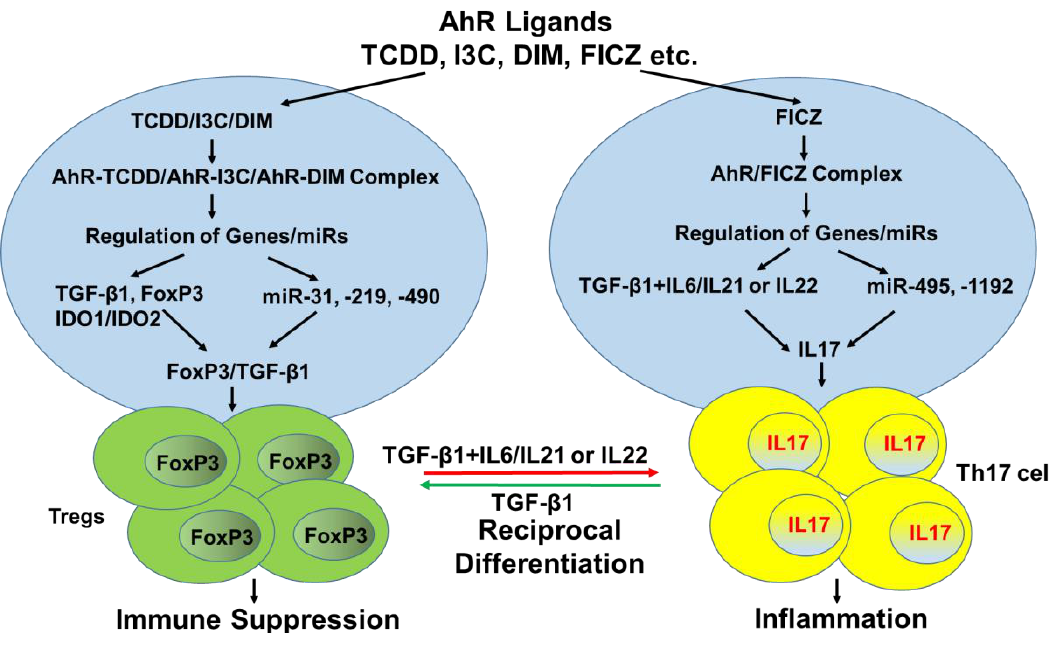
Figure 1. Signaling pathways that lead to the generation of Tregs versus Th17 cells following activation of AhR by a variety of ligands.